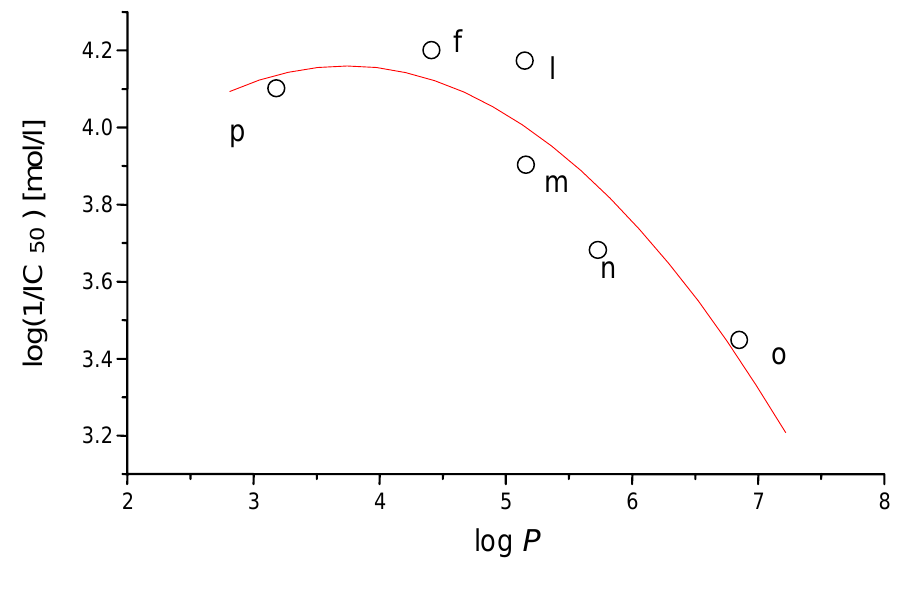
Figure 2. Quasi-parabolic dependence between antialgal activity and log P of studied amides 2f , 2l , 2m , 2n , 2o and 2p .